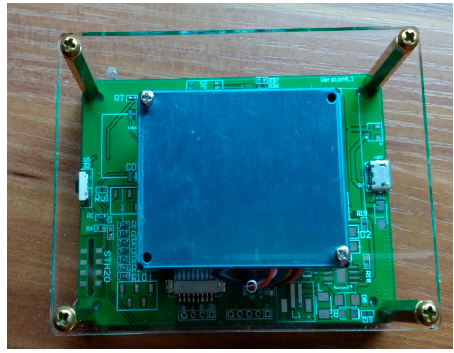
Figure 5. The PM2.5 detector.